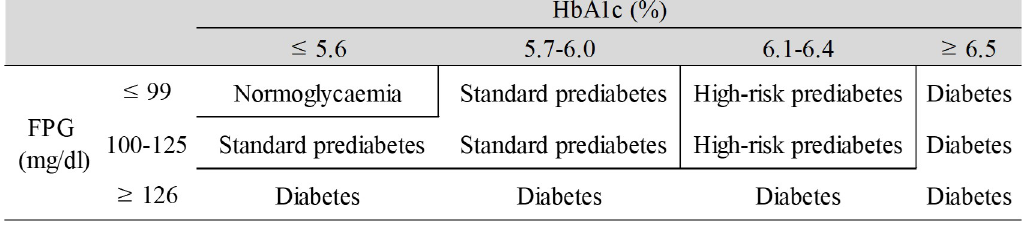
Fig 2. Definition of